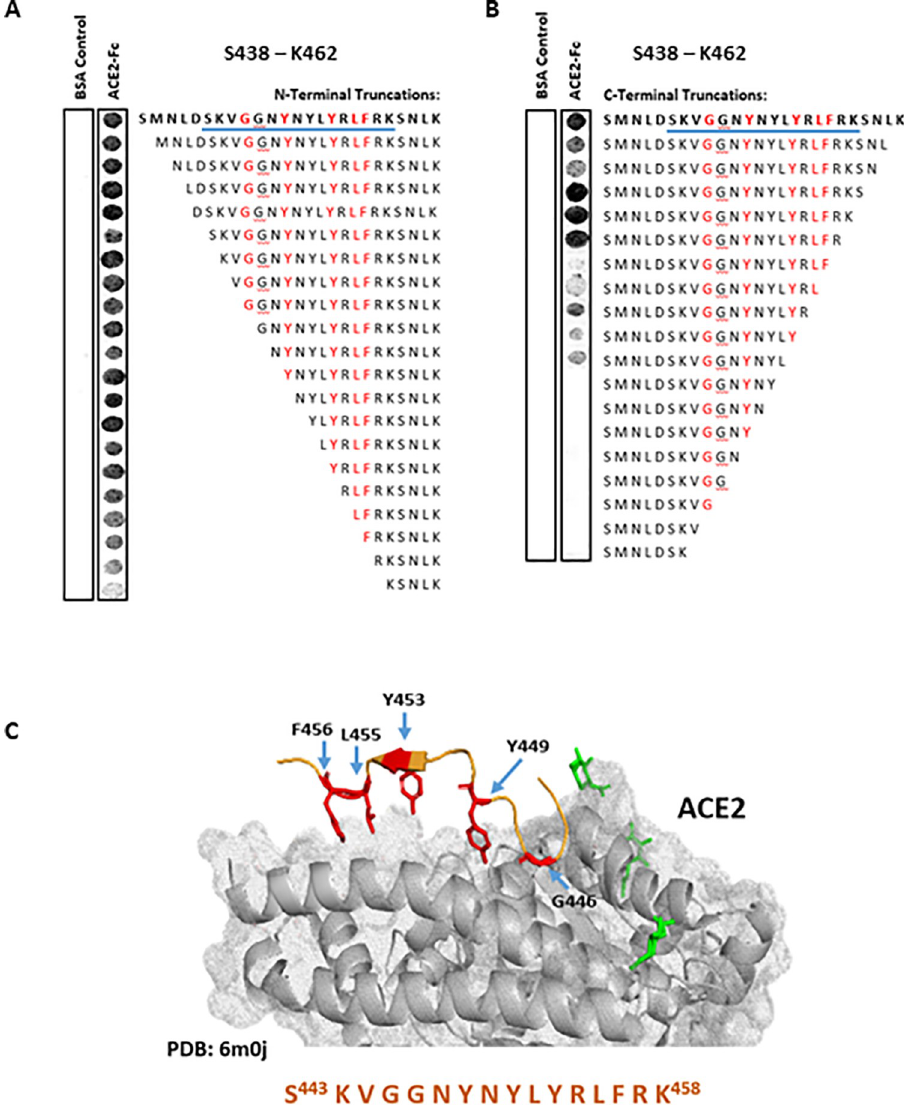
Fig 2. Selecting a potential RBD–ACE2 PPI inhibitor peptide derived from SARS-CoV-2 RBM S438 –K462 peptide. (A) N-terminal and (B) C-terminal stepwise truncation peptide array of RBM S438 –K462, overlaid with ACE2-Fc human purified protein. Underlined (blue) sequence represents shorter sequence peptide selected for assessment in vitro . (C) Structure of S443 –K458 SARS-CoV-2 RBM and the respective binding interface of ACE2 receptor; RBM interacting residues highlighted in red–adapted